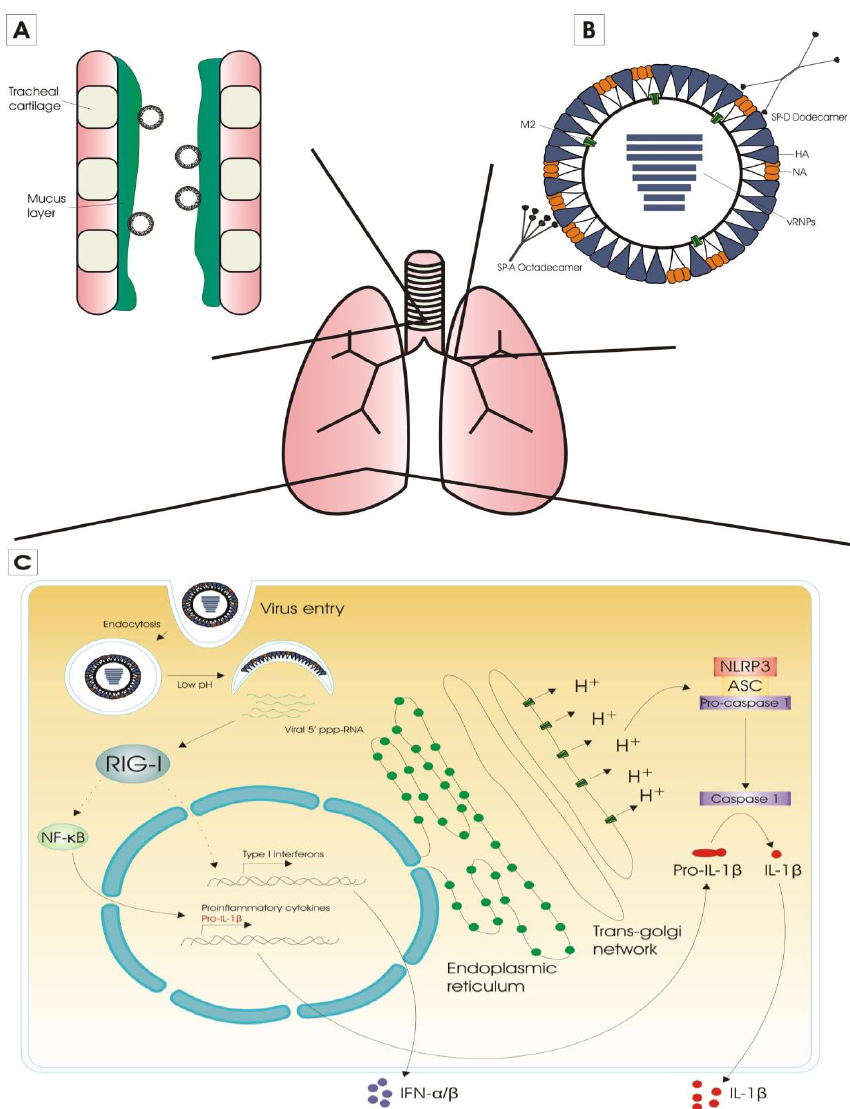
Figure 1. Innate immunity against influenza virus infection. ( A ) The first barrier that the influenza virus has to overcome, is the mucus layer that lines the respiratory tract. To cross this barrier, influenza viruses rely on the enzymatic activity of the neuraminidase glycoprotein; ( B ) The second barrier consists of carbohydrate-binding proteins called lectins. Surfactant proteins A (SP-A) and D (SP-D) are the main two lectins involved in anti-influenza activity. SP-A acts as a decoy receptor for influenza virus, and SP-D binds to oligosaccharides on influenza hemagglutinin (HA) and neuraminidase (NA) proteins; ( C ) Once influenza virions have reached respiratory epithelial cells they recognize sialic acid-containing host cell receptors by the HA glycoprotein. This is followed by endocytosis of the influenza virus and the virion particle ends up in the early endosomes. After acidification of the endosome and subsequent membrane fusion, the genomic RNA segments of the influenza virus are released into the cytosol. The two major PRRs that are responsible for the cytoplasmic sensing of influenza virus infection are retinoic acid inducible gene-I (RIG-I) and NOD-like receptor family pyrin domain containing 3 (NLRP3) protein. Activation of RIG-I—by interaction with 5 (cid:48) triphosphorylated RNA (5 (cid:48) ppp-RNA)—results in the production of proinflammatory cytokines and type I interferons (IFNs), which in turn induce the expression of interferon-stimulated genes (ISGs). NLRP3 is a part of the NLRP3 inflammasome, which becomes activated by the proton gating activity of influenza A virus M2. This leads to the conversion of pro-IL-1 β to IL-1 β , which is a proinflammatory cytokine that is involved in the induction of Th17 cells and the expansion of CD4 + T